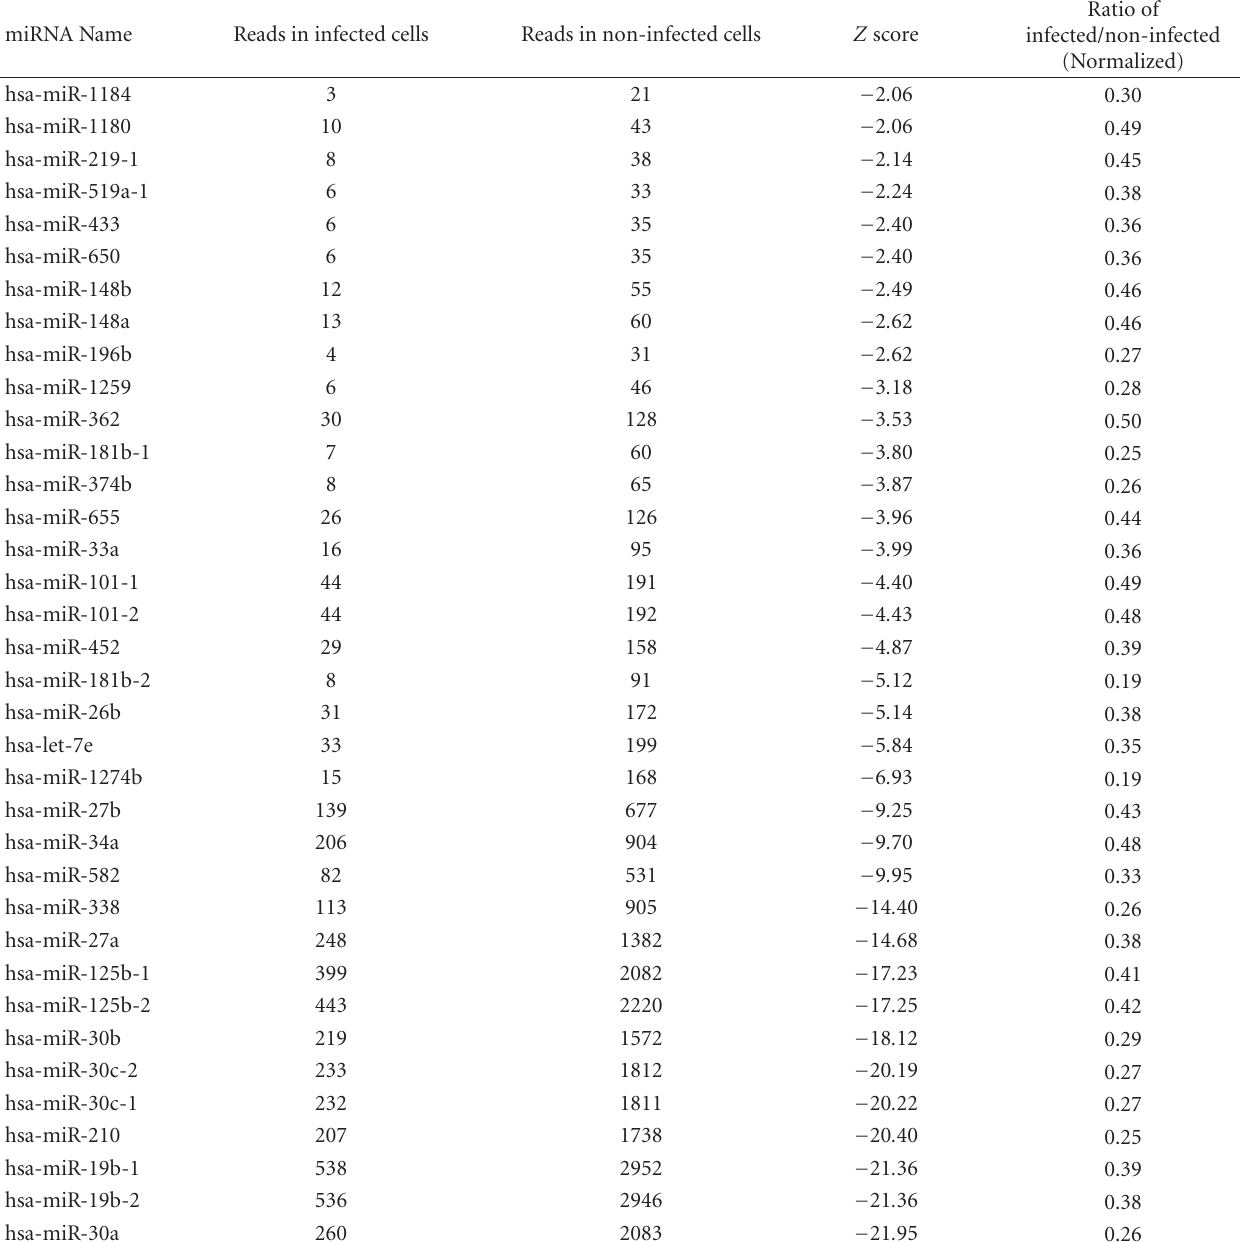
Table 3: Downexpressed miRNAs in infected cells compared with noninfected